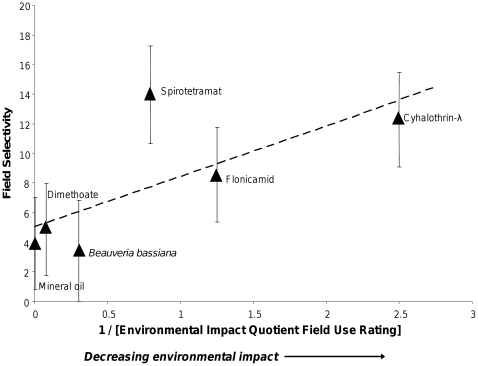
Relationship between observed field selectivity and the inverse of Environmental Impact Quotient at field rates.Field selectivities presented as least square means (± SE) of field selectivities observed at four sites in 2009. Equation of regression line is Field selectivity = (3.3±1.7)/EIQ+(0.3±3.1)+site effect, with F93 = 4.23, p = 0.0035.